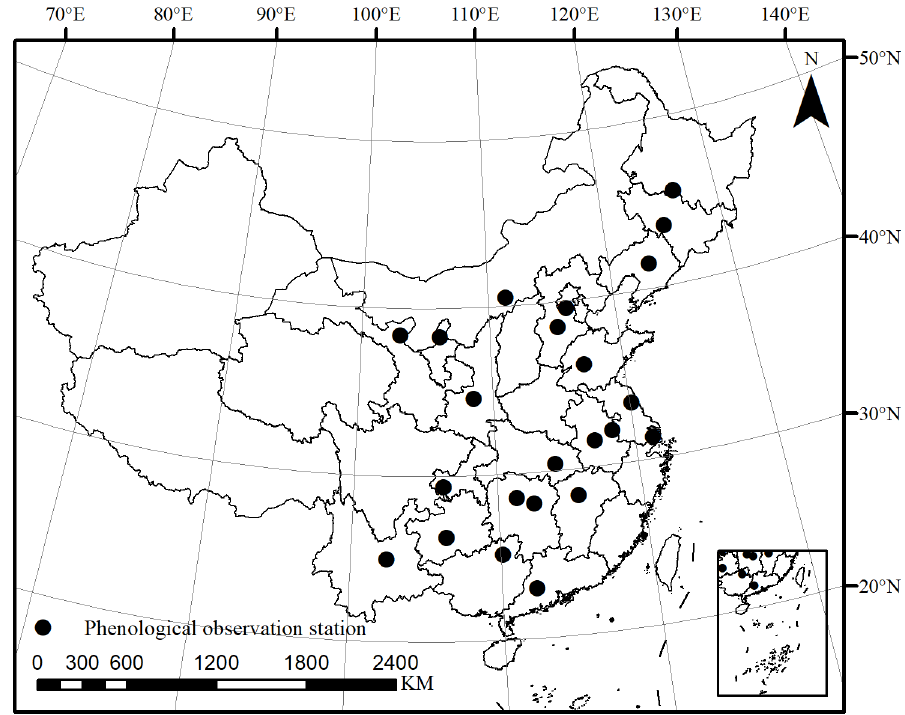
Figure 2. Geographical distribution map of phenological stations. The meteorological data were obtained from the China Meteorological Science Data Sharing Network “China Ground Meteorological Data Dataset V3.0”. A total of 23 basic city stations were selected, and we obtained the meteorological elements of average temperature ( ◦ C), daily minimum temperature ( ◦ C), daily maximum temperature ( ◦ C), daily average ground temperature ( ◦ C), daily average precipitation (mm), daily average sunshine hours (h), daily average relative humidity (%), and daily average pressure (Pa) from 1 January to 30 April 1961 to 2015 in these